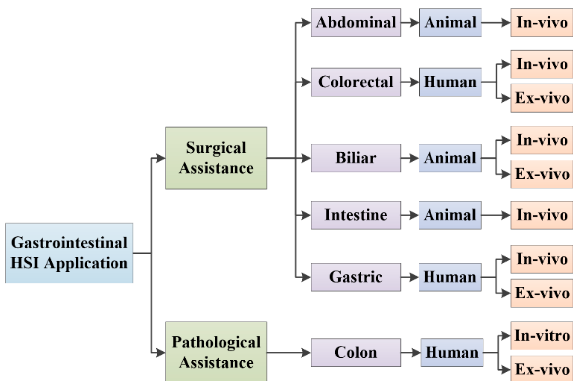
Figure 4. Taxonomy of the current gastrointestinal HSI applications.